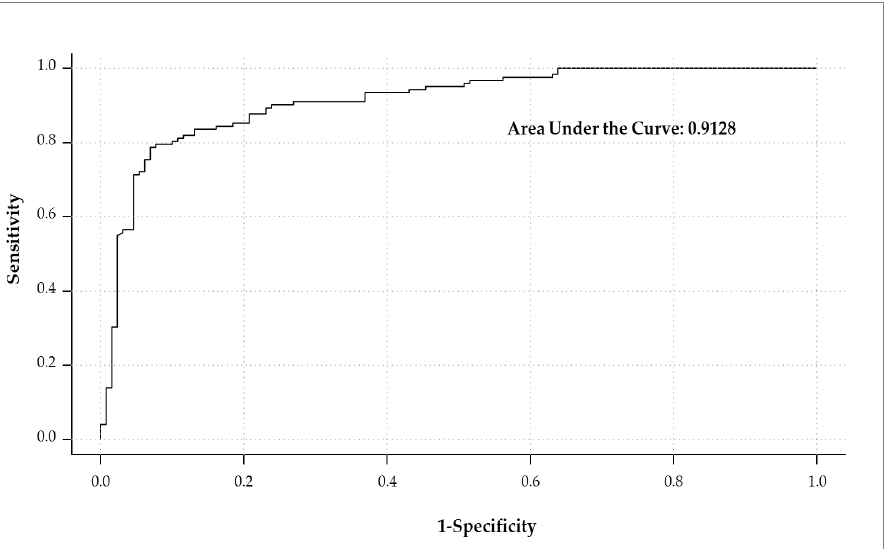
Figure 9. Receiver operating characteristic (ROC) curve illustrating the area under the curve (AUC) for the random forest classifier.